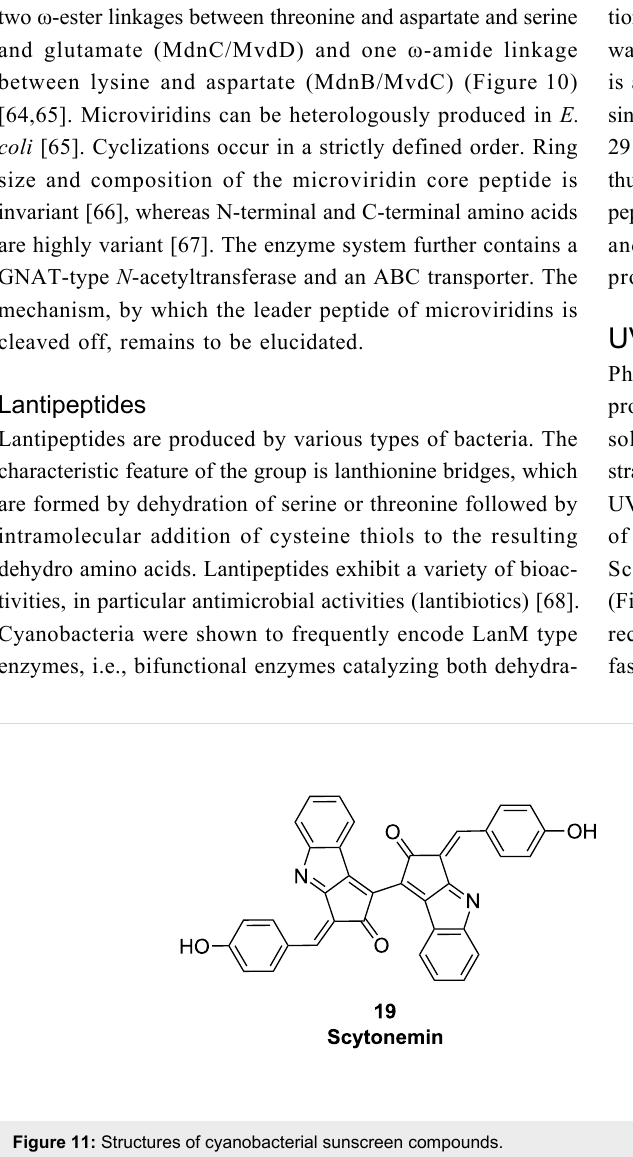
Figure 10: Formation of ester linkages and ω -amide linkage in microviridins 17 by the ATP grasp ligases MvdD and MvdC, respectively.